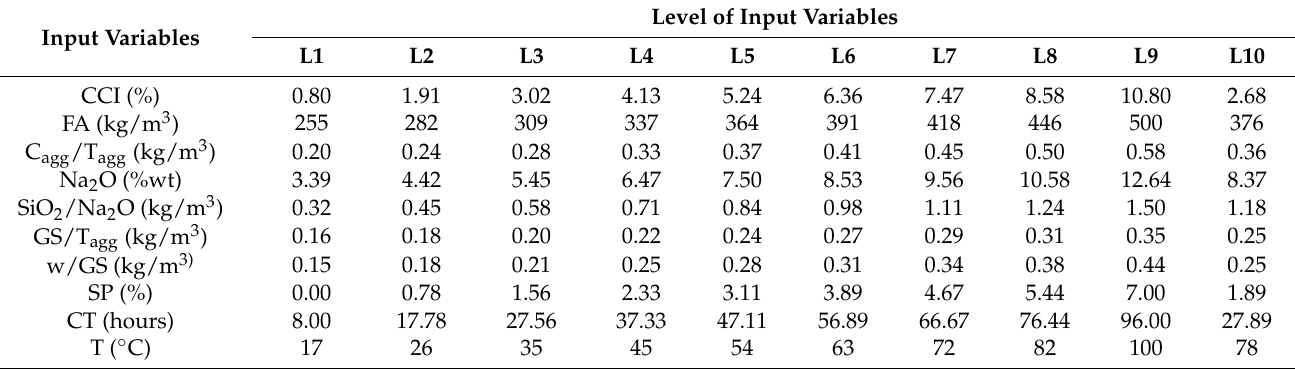
Table 3. The levels of the input variables (L1–L10) for generating the design